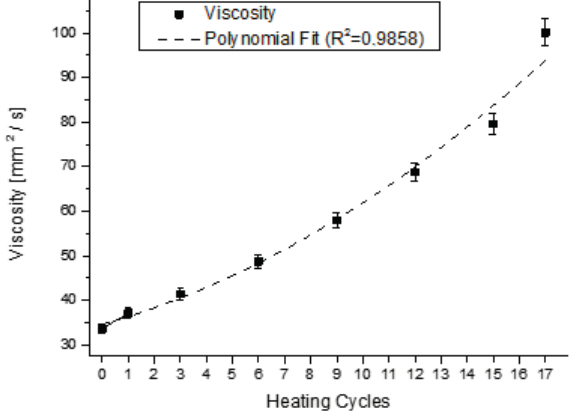
Figure 13. Viscosity of the oil superimposed with the dielectric constant for the samples in Figure 8.